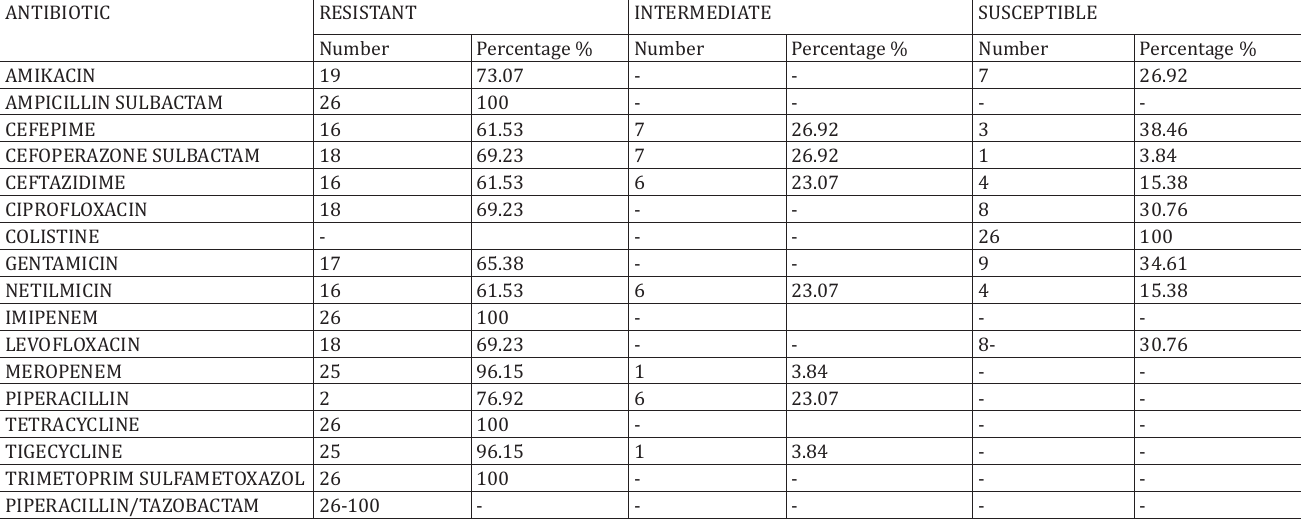
Antibiotic susceptibility test result of P. aeruginosa isolates